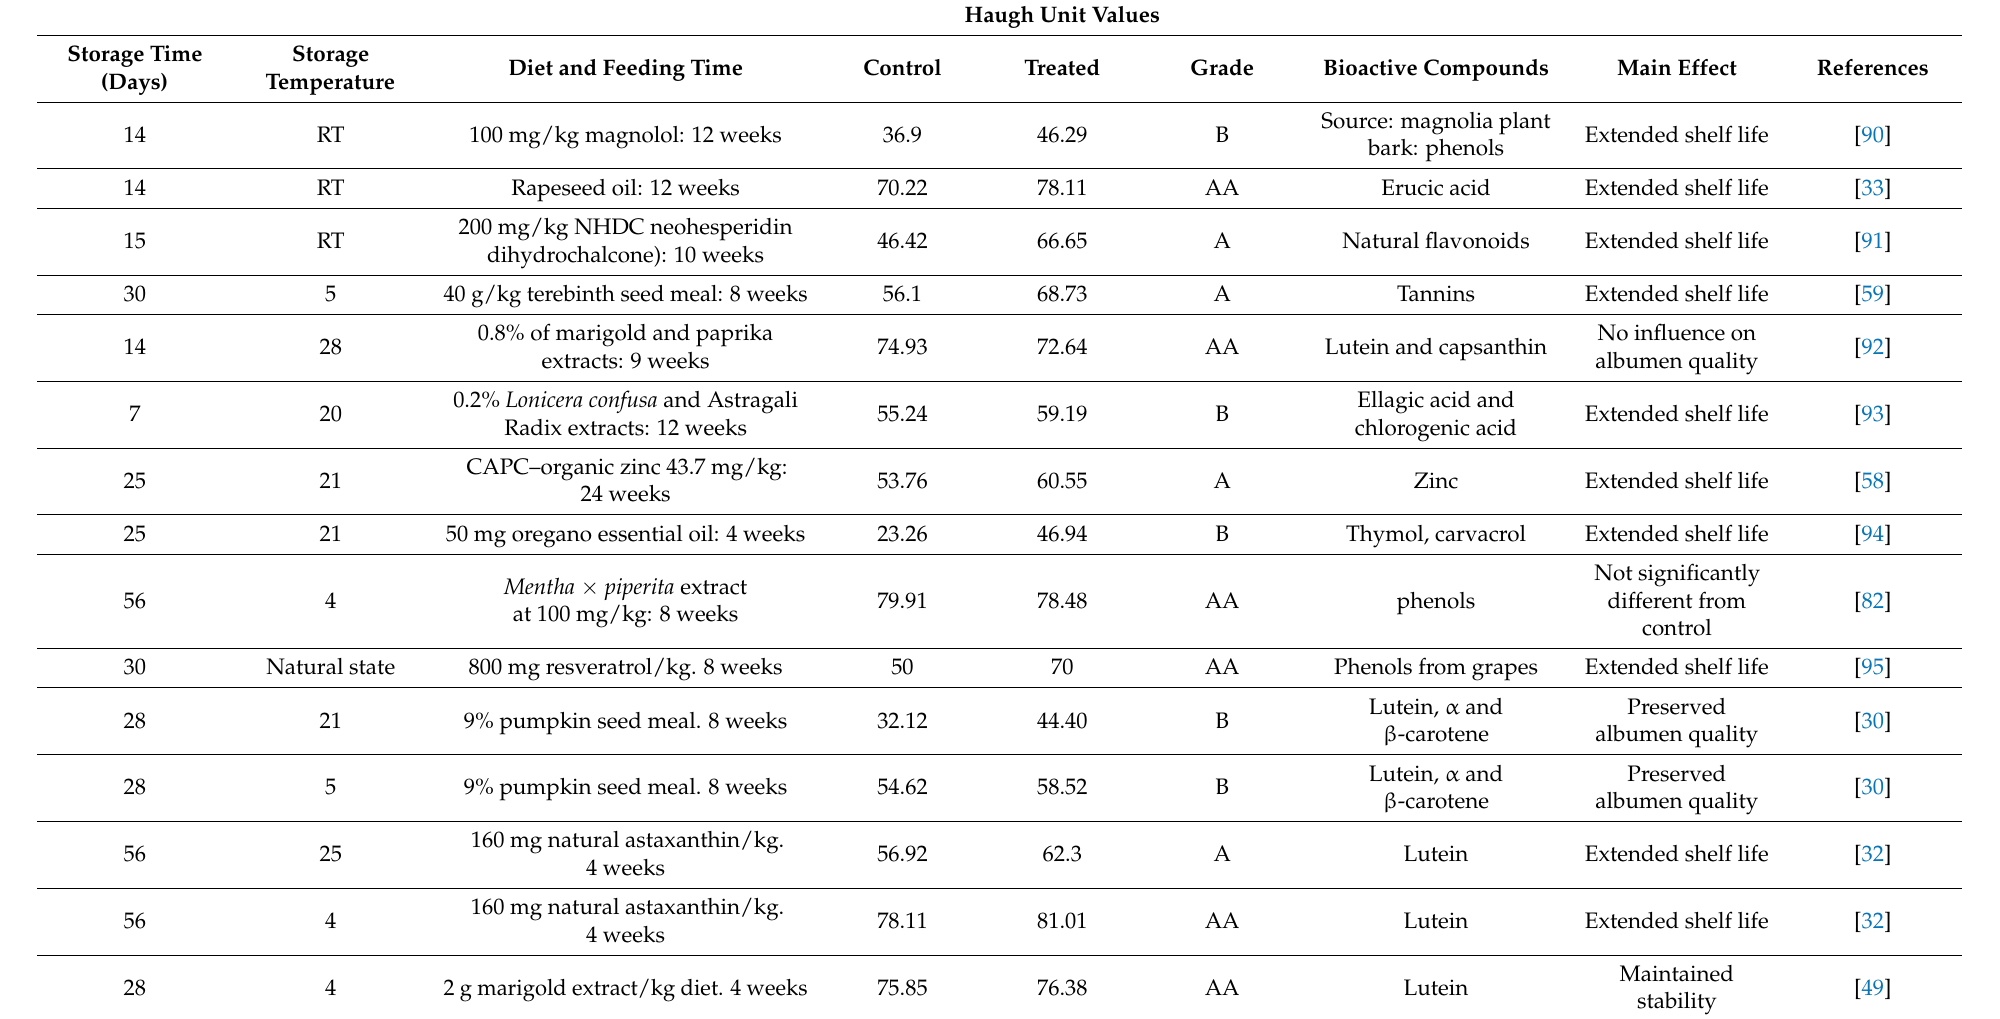
Table 4. Effects of natural antioxidants from plants on albumen quality during